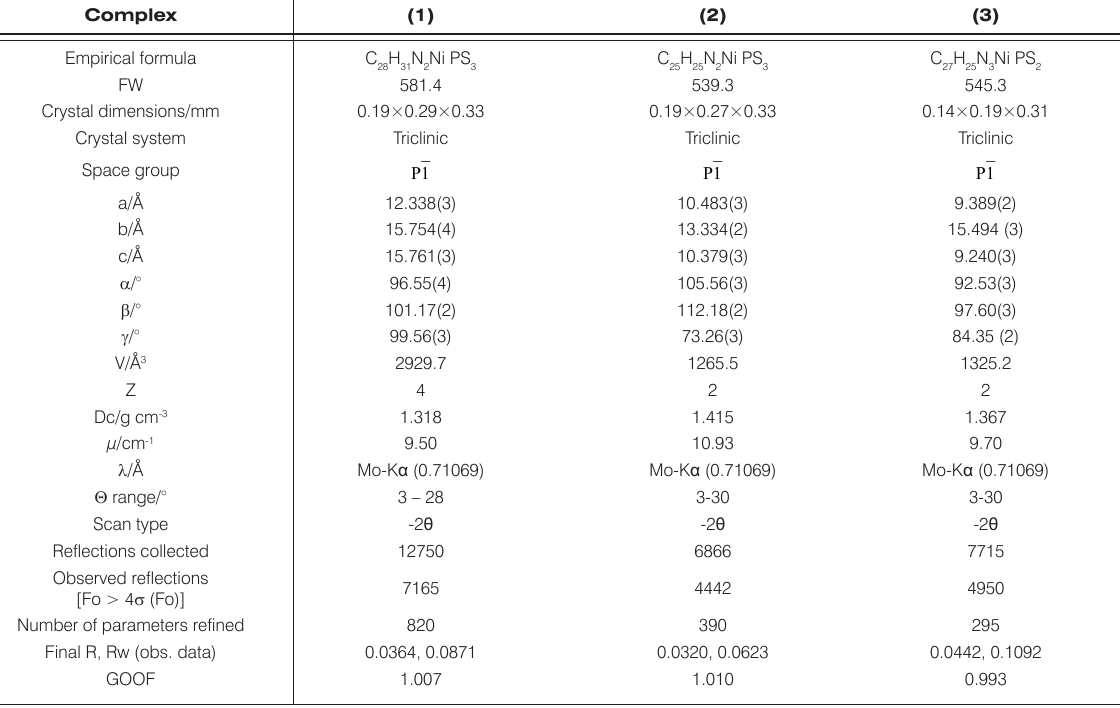
Table 1. Crystal data, data collection and refinement parameters of ( 1 ), ( 2 ) and ( 3 ).